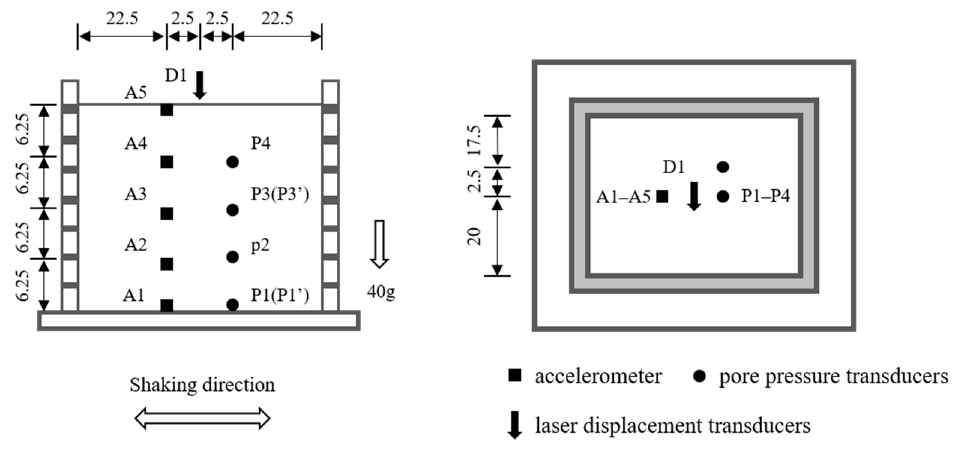
Figure 4. Schematic of instrumentations